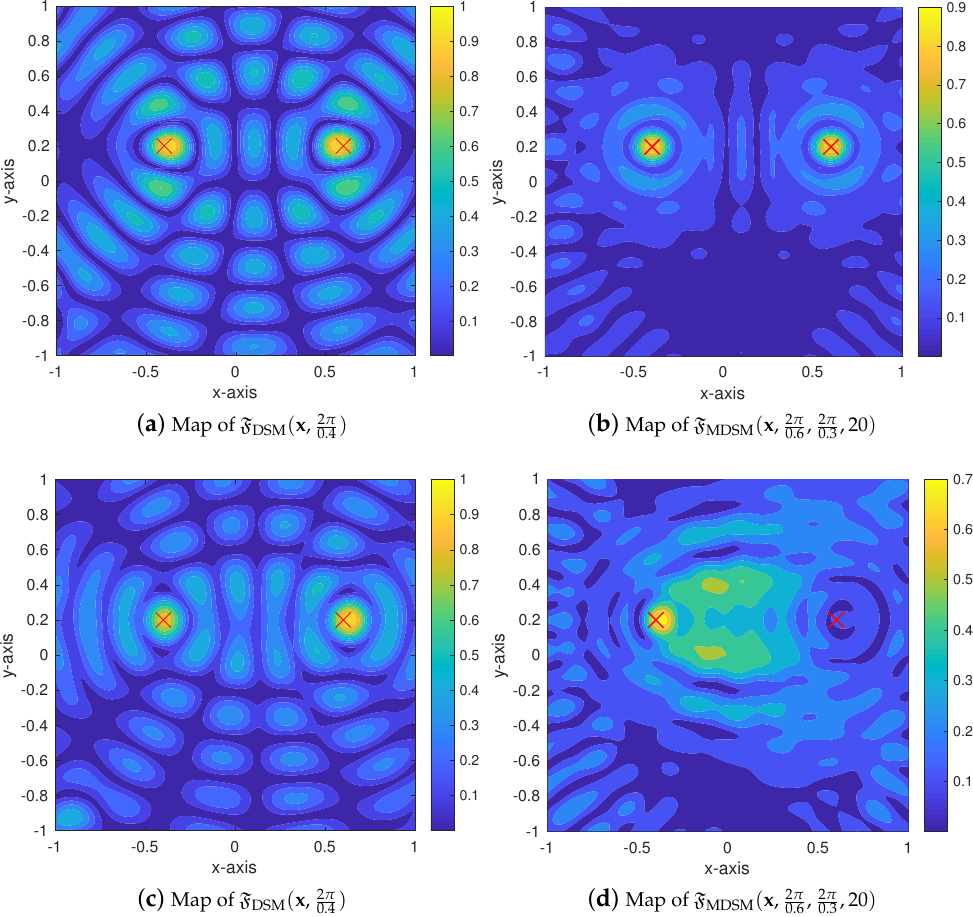
Figure 10. (Example 8) Simulation results with d = ( 1,0 ) . The red-colored marks × denote the locations of